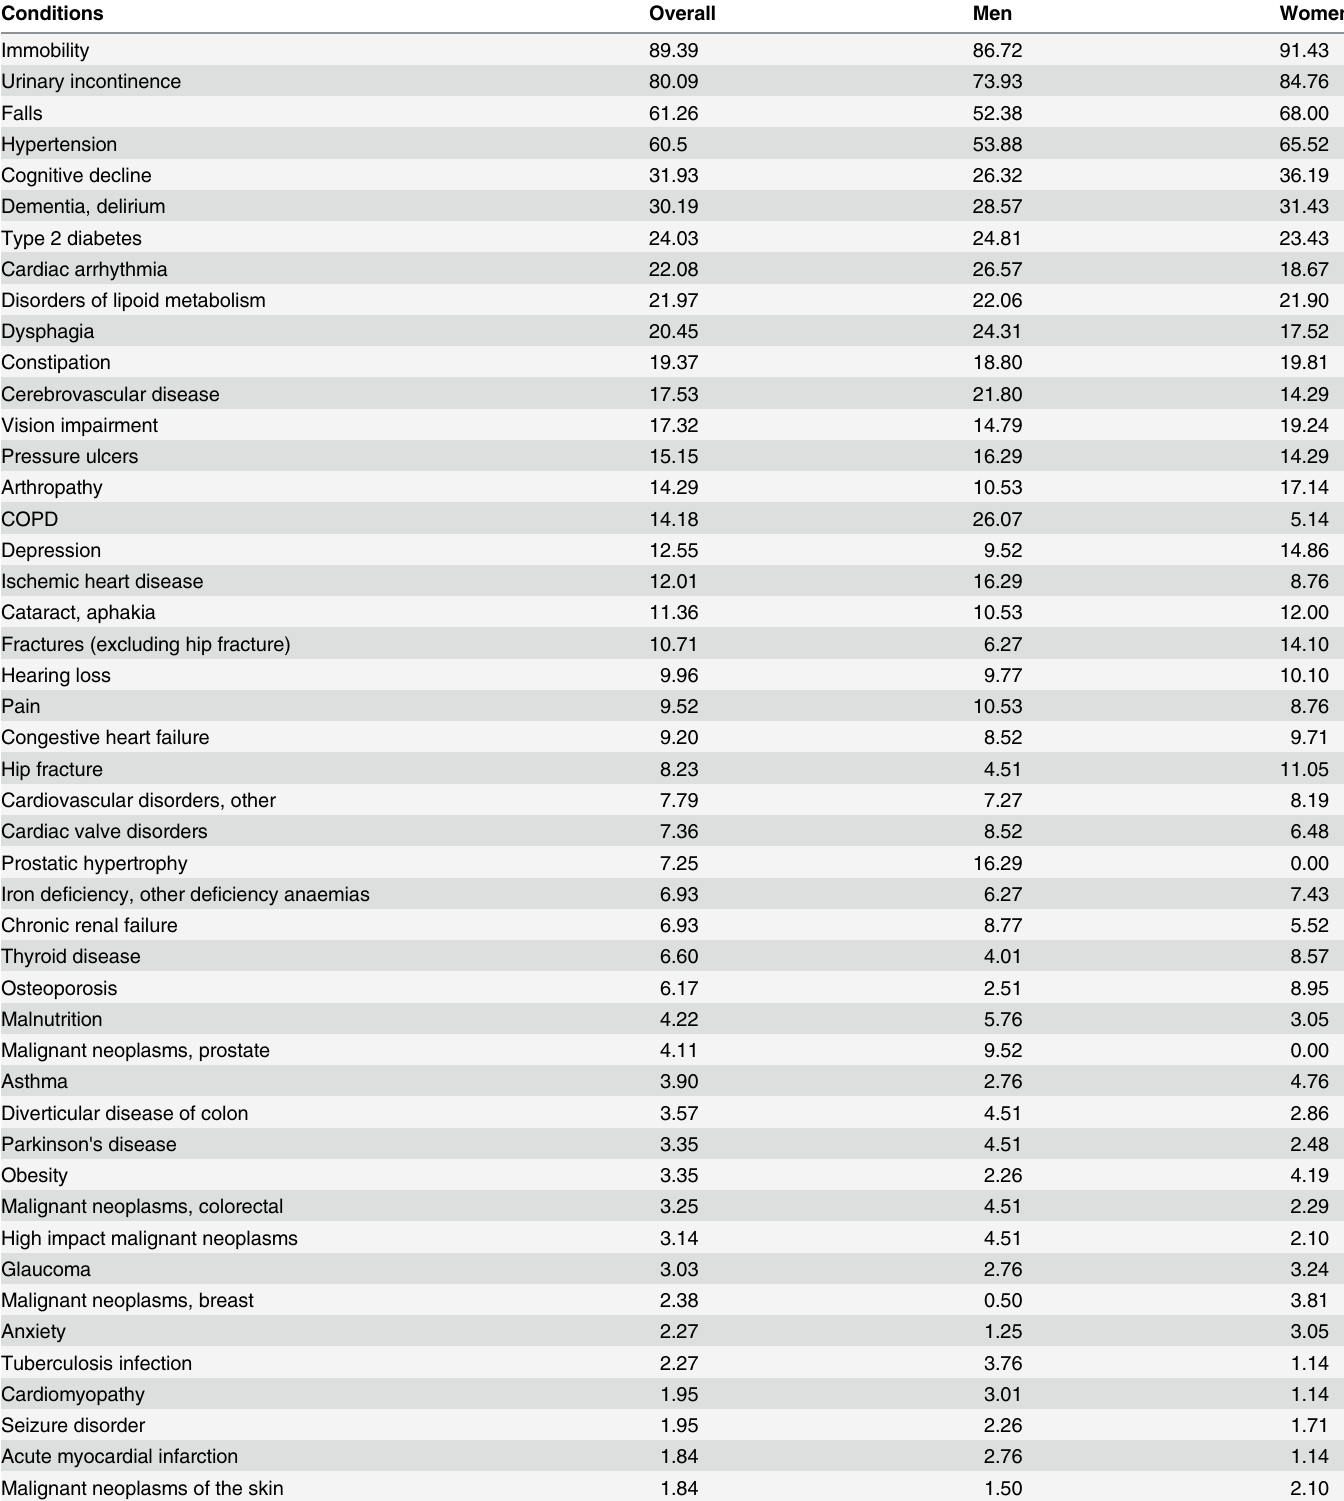
Table 1. Prevalence rates of chronic diseases and syndromes in the study population by sex.